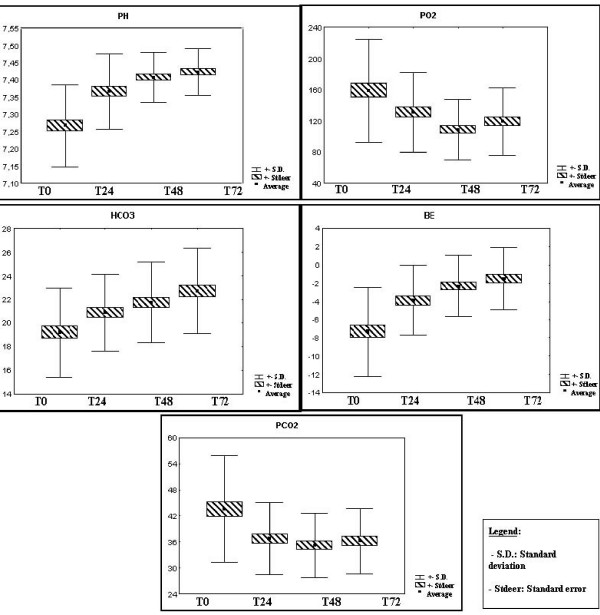
Gasometry variation. Normal values: pH (7,35–7,45), PCO2 (35–46 mmHg), PO2 (75–100 mmHg), HCO3 (20–30 mmol/L), and BE (-2 – +2).